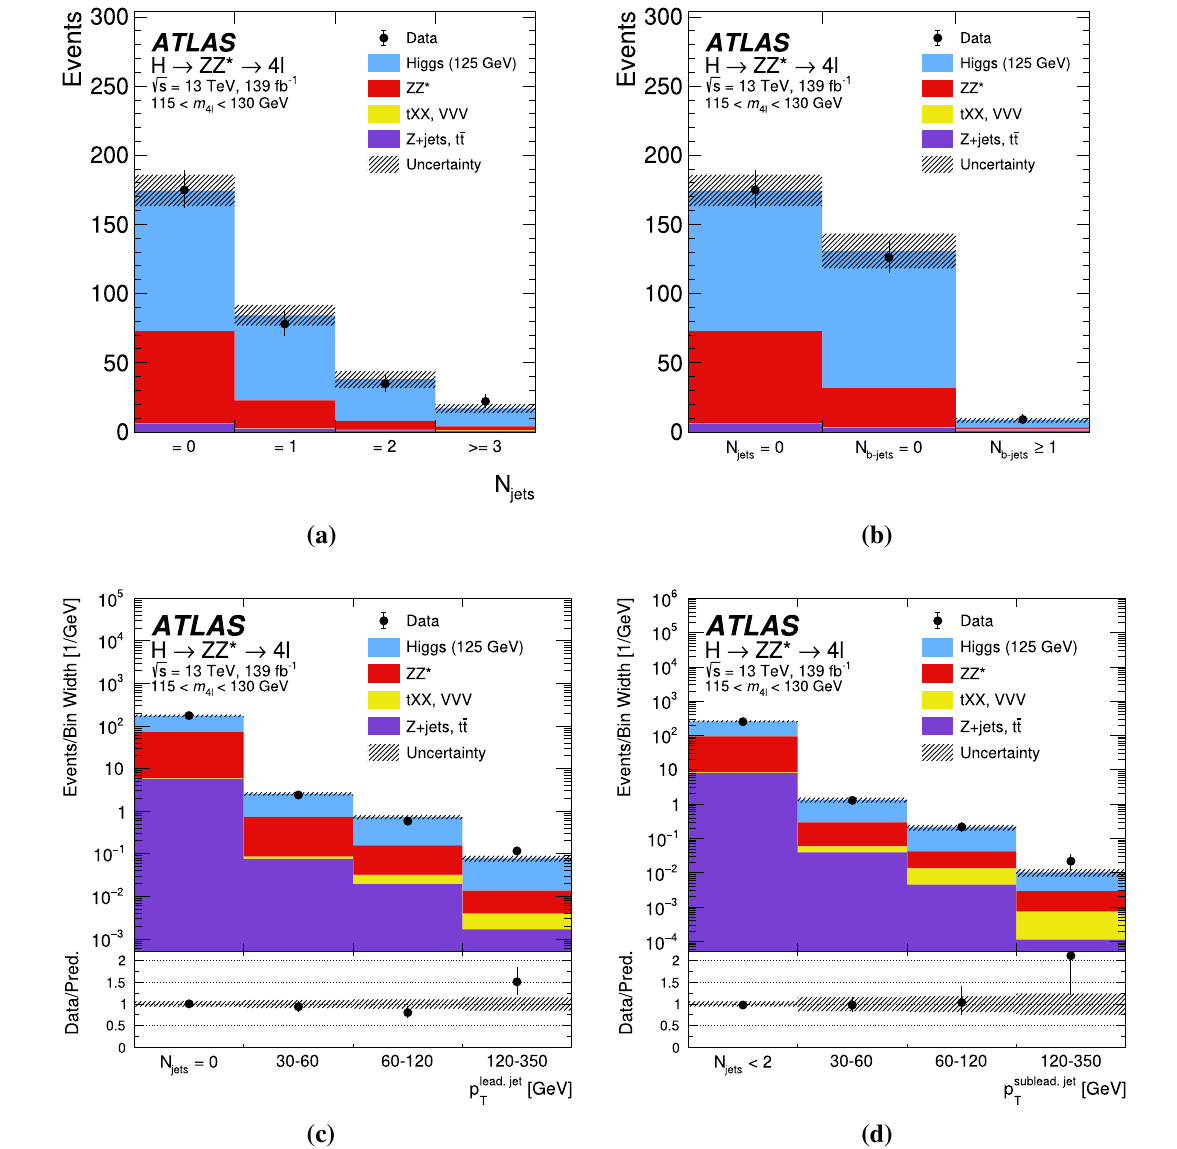
Fig. 7 The observed and expected (pre-fit) distributions of a N jets , . jet . jet b N b - jets , c p lead , and d p sublead in the mass region 115 < T T m 4 (cid:3) < 130 GeV, for an integrated luminosity of 139 fb − 1 collected